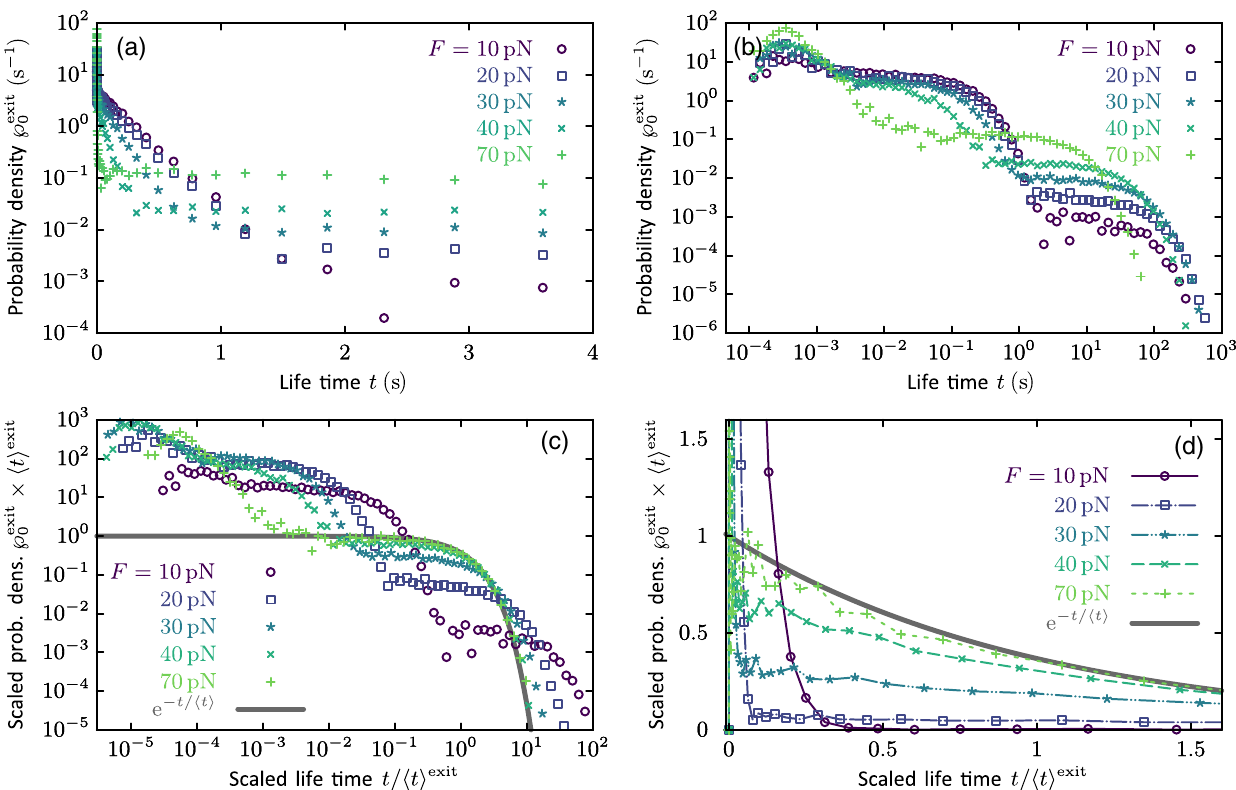
FIG. 16. Probability density of bond lifetime. (a) Probability densities on a semilogarithmic scale. (b) Probability densities on a log-log scale. (c) Scaled probability density and scaled time on a log-log scale; the mean lifetime corresponds to t= h t i exit ¼ 1 . (d) Scaled probability densities on a linear scale. Each probability density is estimated from 10 000 ruptures. All symbols are deduced from histograms with equidistant binning in logarithmic time.